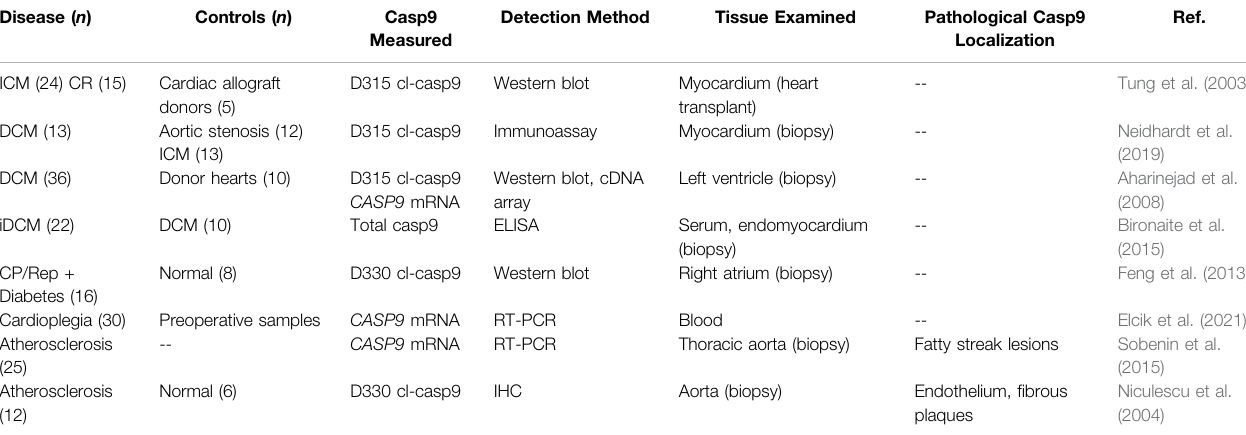
TABLE 6 | Studies reporting increased level of caspase-9 in cardiovascular pathologies. Disease ( n